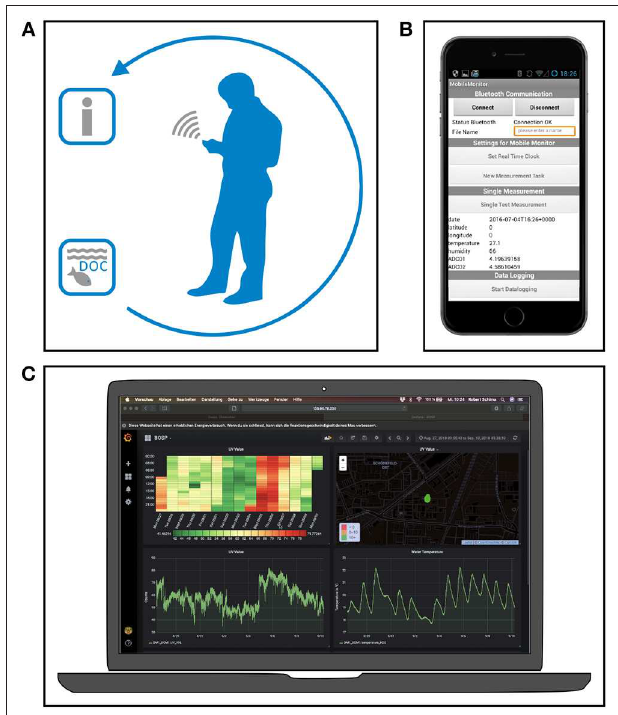
FIGURE 1 | Assisted Monitoring based on mobile apps and web services will lead to new perspectives in environmental monitoring and observation. The development of service-oriented infrastructures will accelerate the data acquisition toward the provision of reliable information during field measurements (A) . The visualization of data near real-time and the usage of mobile devices (B) in the field will increase the spatio-temporal resolution and the quality of environmental monitoring in general (C)